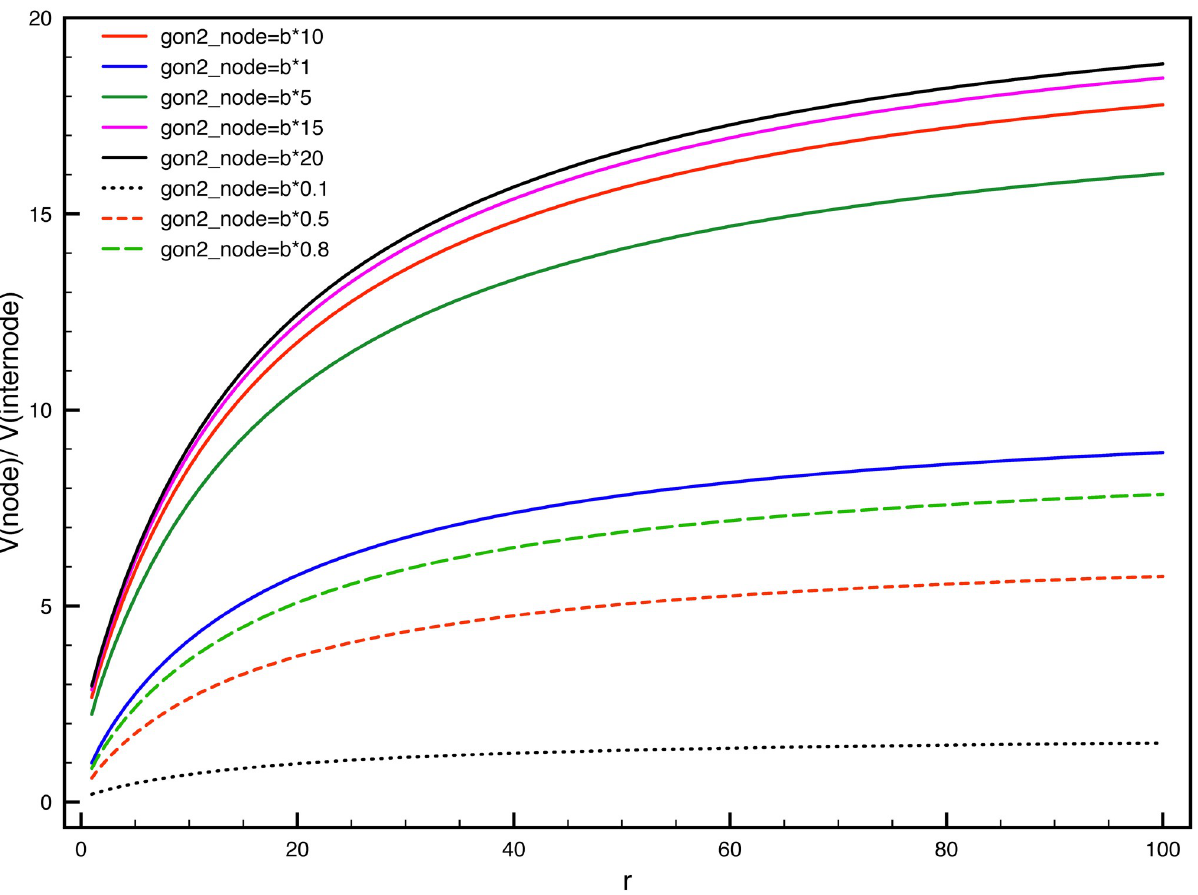
Fig 7. The ratio of velocity between node and internode changes with the rate ratio of phospohorylation and dephosphorylatoin r = γ ph : γ internode. The g 2 in the internode is fixe as b = 0.00498 s − 1 on